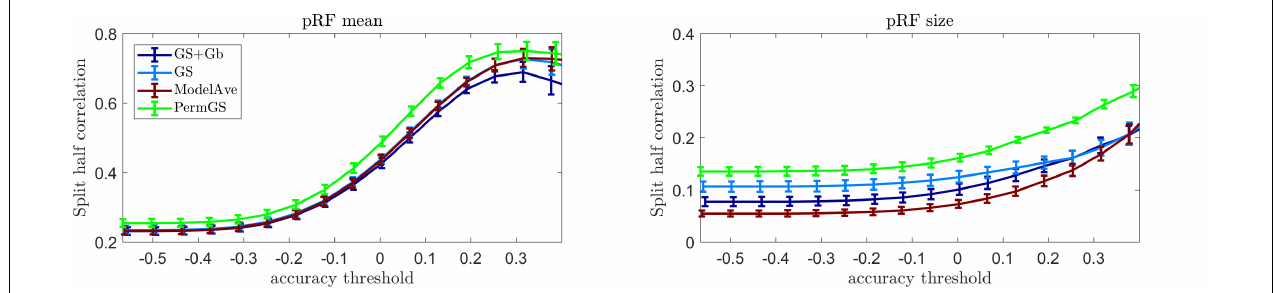
FIGURE 10 | Reliability analysis for the auditory data. The mean reliability across 10 subjects is presented as a function of the mean prediction accuracy for four pRF estimation methods for the pRF mean (left) and size (central). In the right panel display the mean prediction accuracy (across 20000 voxels), for every